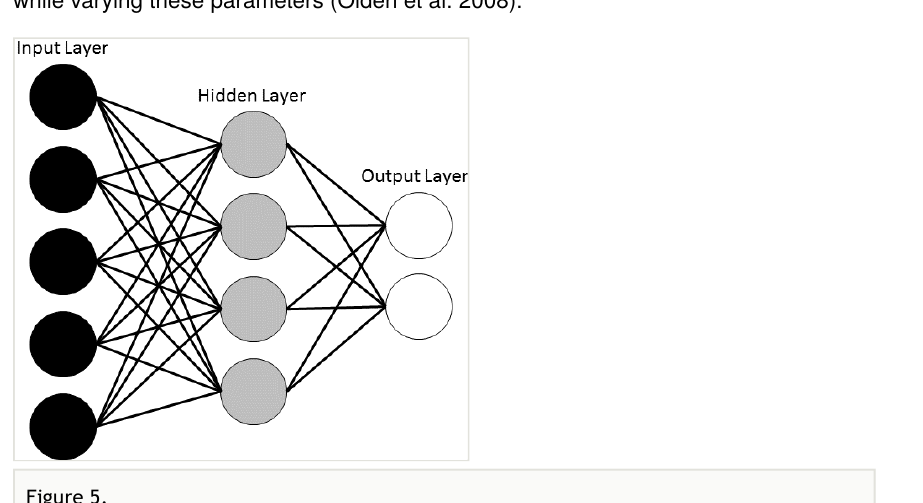
Arti fi cial Neural Network Schematic : A neural network is made up of three layers (input, hidden, output). Each layer contains interconnected units (neurons). Each connection has an assigned connection weight. The number of hidden units and the connection weights are iteratively improved to minimize the error between the output and the